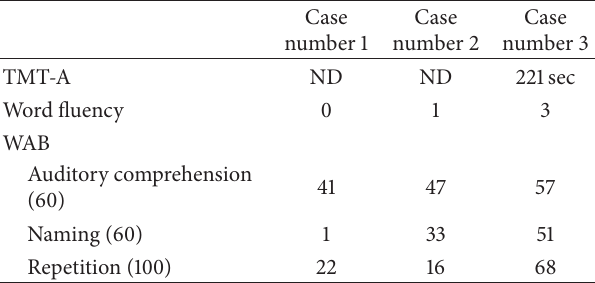
Table 2: Neuropsychological findings of three SD